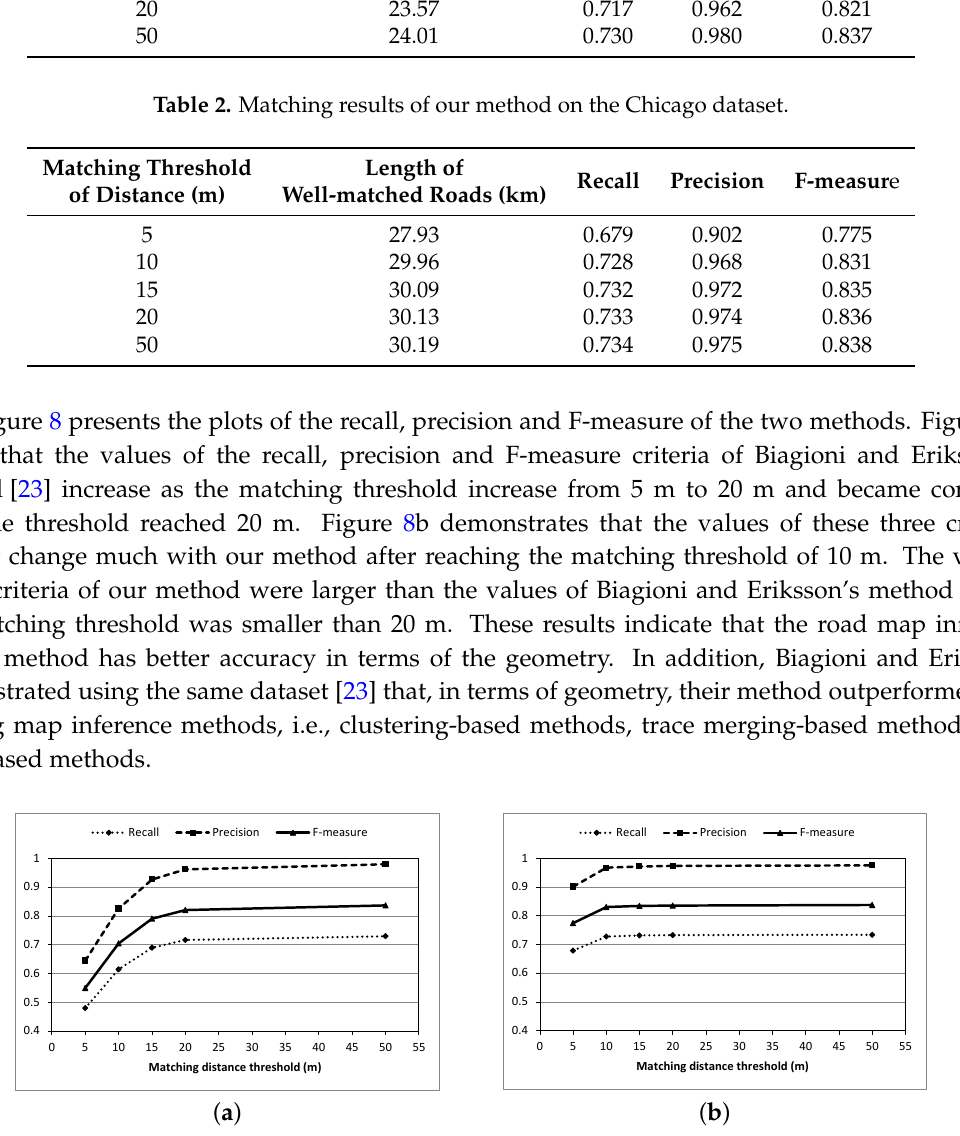
Figure 8. F-measure of Biagioni and Eriksson’s method and our method. ( a ) Recall, precision and F-measure of Biagioni and Eriksson’s method for Dataset 1; ( b ) recall, precision and F-measure of our method for Dataset